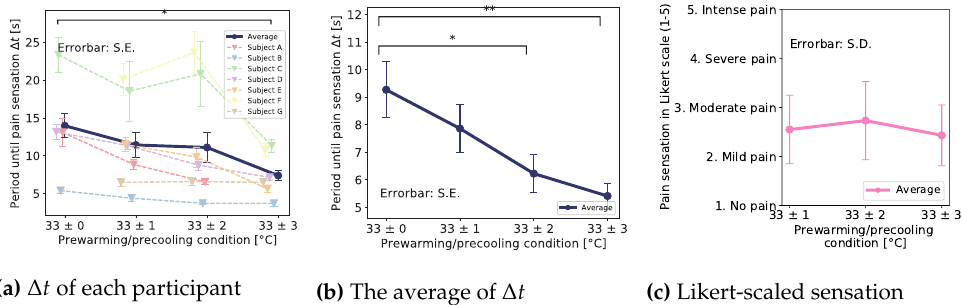
Figure 5. Results of pre-cooling/pre-warming effect. ( a ) Each participant’s period until pain sensation and their average ( b ) The period of average and significant difference (except the outlier) ( c ) An average of 5 stages Likert-scaled questionnaires about the sensation. The * and ** indicated a significant difference of p < 0.05 and p < 0.01 for each.